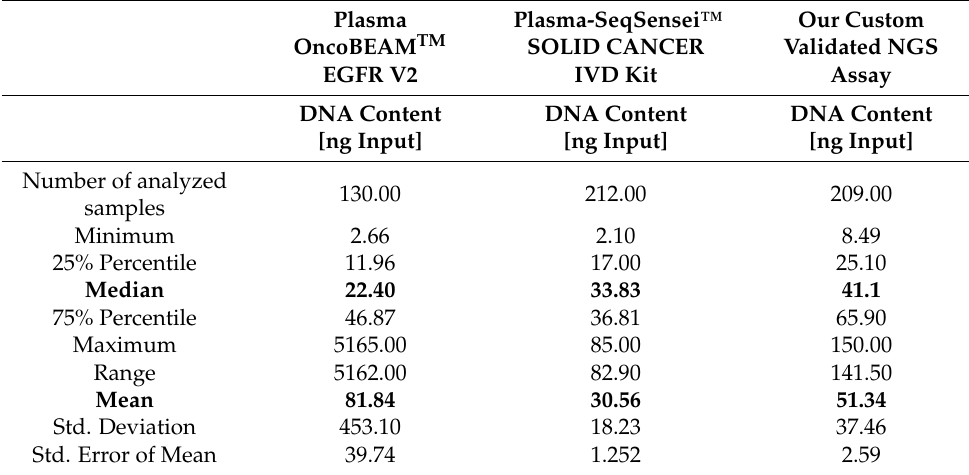
Table 2. CfDNA input of the population for the three